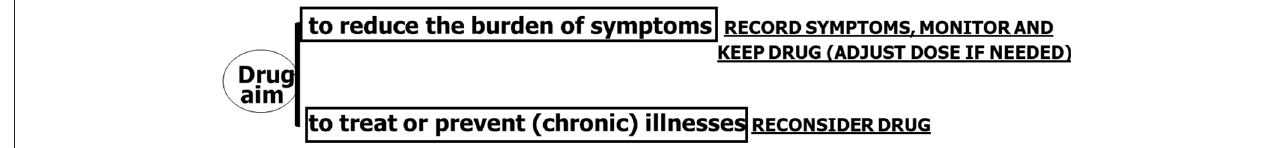
FIGURE 1 | Decision tree algorithm regarding the adjustment of cardiovascular drugs in patients with advanced heart failure.